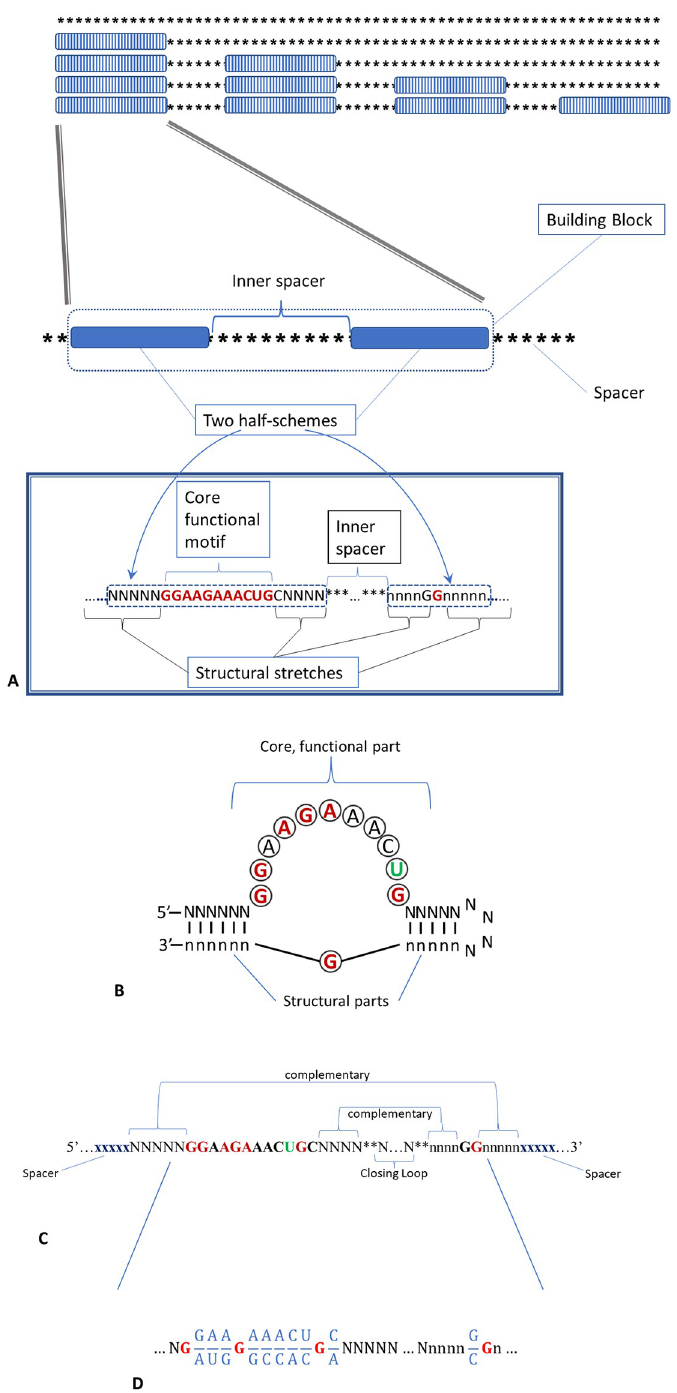
Fig 2. The specific implementation of the BioRS function in the molecular biological aspect. Aptamer is presented as a composite BB of two half-schemes, which is representative for the organization of aptamers. The inset shows the internal structure of each half-scheme of the Sassanfar–Szostak motif [85, 86]. See text for details. All the domains are assumed to be identic. (B-C) Structural details of conservative functional regions of an aptamer using Sassanfar– Szostak motif as an example: (B) 2D structure and (C) nucleotide sequence. Positions in the recognition bulge are colored according to whether they are invariant (red), two-base varying (green), or non-conserved (black). Here ... xxxxx corresponds to the halves of the insulating spacer sequences, NNNNN & nnnnn are the complementary halves of the sequences of the first and second stem, �� ... �� is arbitrary and corresponds to the closing loop sequence.